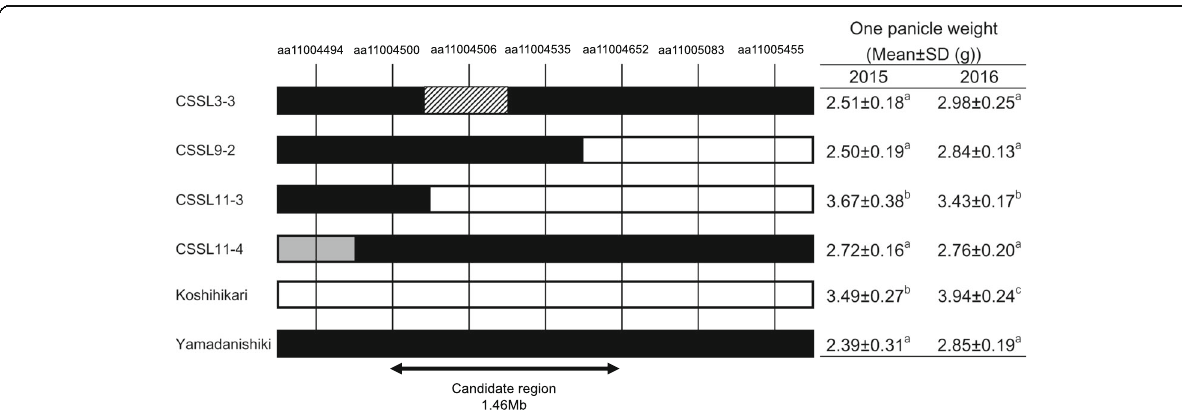
Fig. 5 Substitution mapping of qOPW11 using the chromosome segment substitution lines (CSSLs) on chromosome 11. Black, white, and gray blocks represent the Yamadanishiki homozygous genotypes, Koshihikari homozygous genotypes, and heterozygous genotypes, respectively. The striped block on CSSL3 – 3 shows the missing genotype at aa11004506. One panicle weight values are shown for 2015 and 2016. Different letters indicate significant differences between samples in the Tukey-Kramer